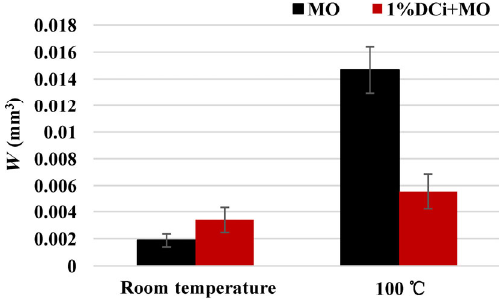
Fig. 7 Wear volume of steel disks as a function of temperature.